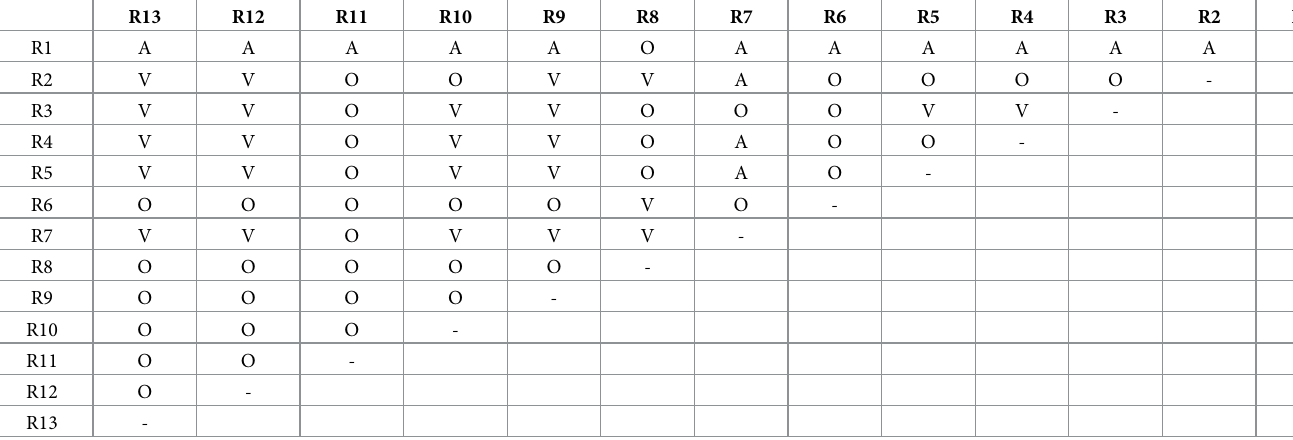
Table 2. Structural self-interaction matrix